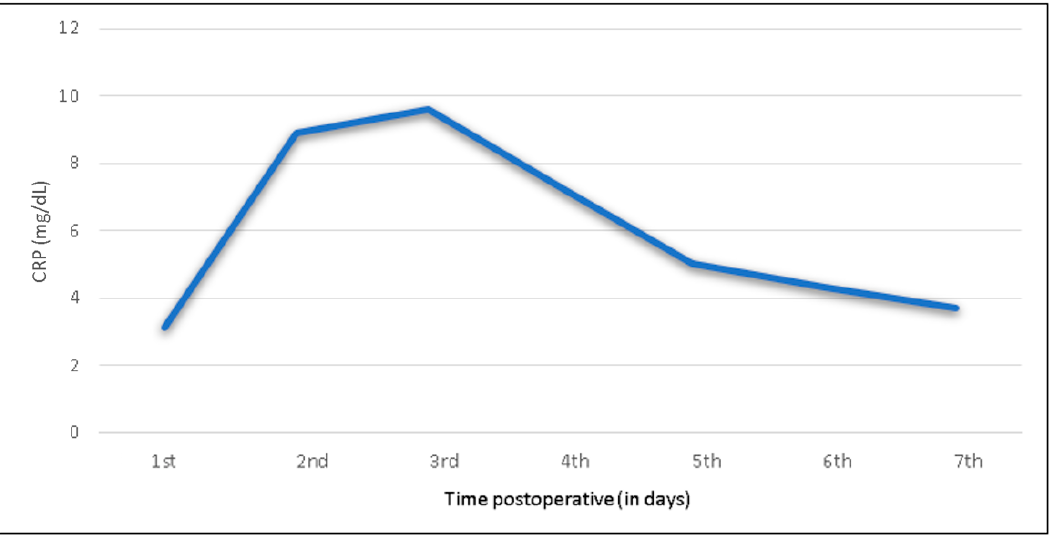
Figure 1. Mean C-reactive protein levels and trend following shoulder arthroplasty in the total study group, illustrating the characteristic trajectory from the first to the seventh postoperative day.